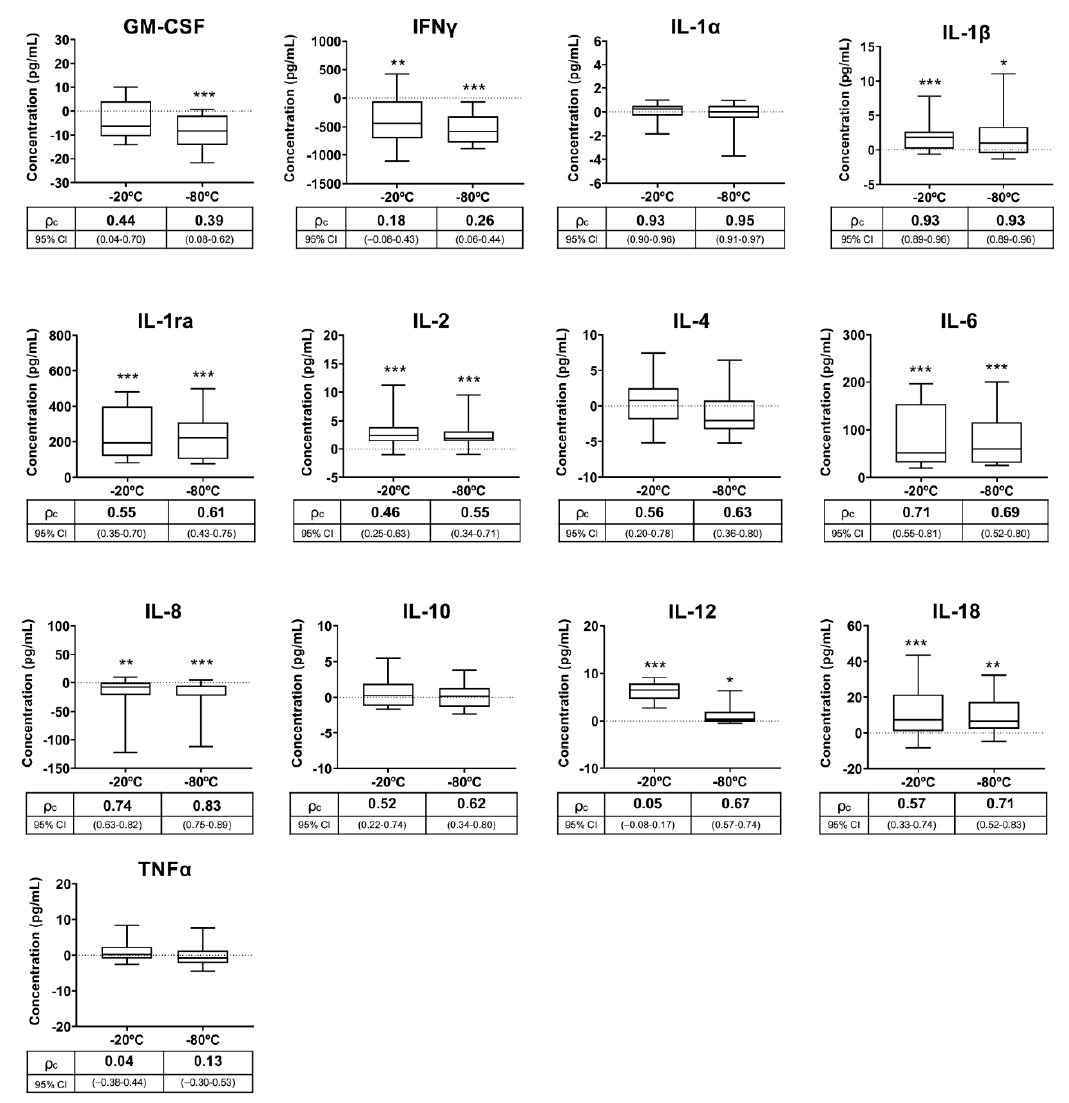
Figure 3. Box-and-whisker plot (horizontal line: median; box: 25/75 percentile; whisker: 10/90 percentile) showing differences in cytokine concentrations measured in pig seminal plasma samples (SP) stored at − 20 °C and − 80 °C for two months with respect to those measured in fresh samples (baseline samples, point 0 on the Y axis). Below the X-axis is the concordance correlation coefficient ( ρ c) and 95% confidence interval (CI), showing agreement between cytokine concentrations of the baseline and experimental SP samples. Cytokines: Granulocyte macrophage colony-stimulating factor (GM-CSF), interferon-gamma (IFN γ ), interleukin (IL)-1 α , IL-1 β , IL-1ra, IL-2, IL-4, IL-6, IL-8, IL-10, IL-12, IL-18 and tumor necrosis factor- α (TNF α ). Asterisks indicate statistical differences with baseline data. *** p < 0.001; ** p < 0.01; * p < 0.05.